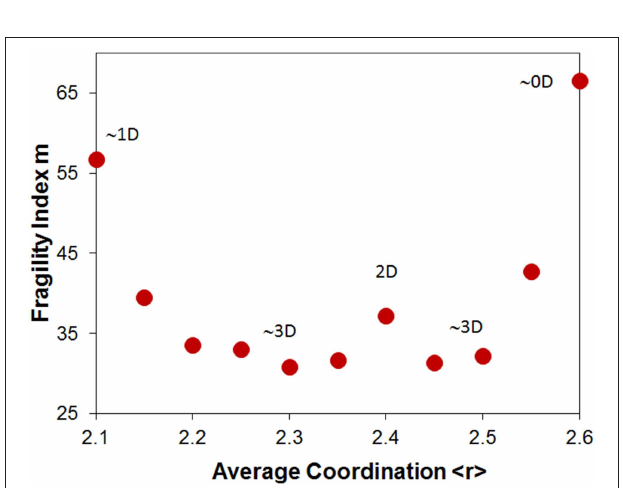
FIGURE 9 | Fragility of Ge-Se glasses as a function of average coordination < r > . Data from Senapati and Varshneya (1996). Additional data sets such as that presented in Zeidler et al. (2017) show a collective broad minimum near < r > =